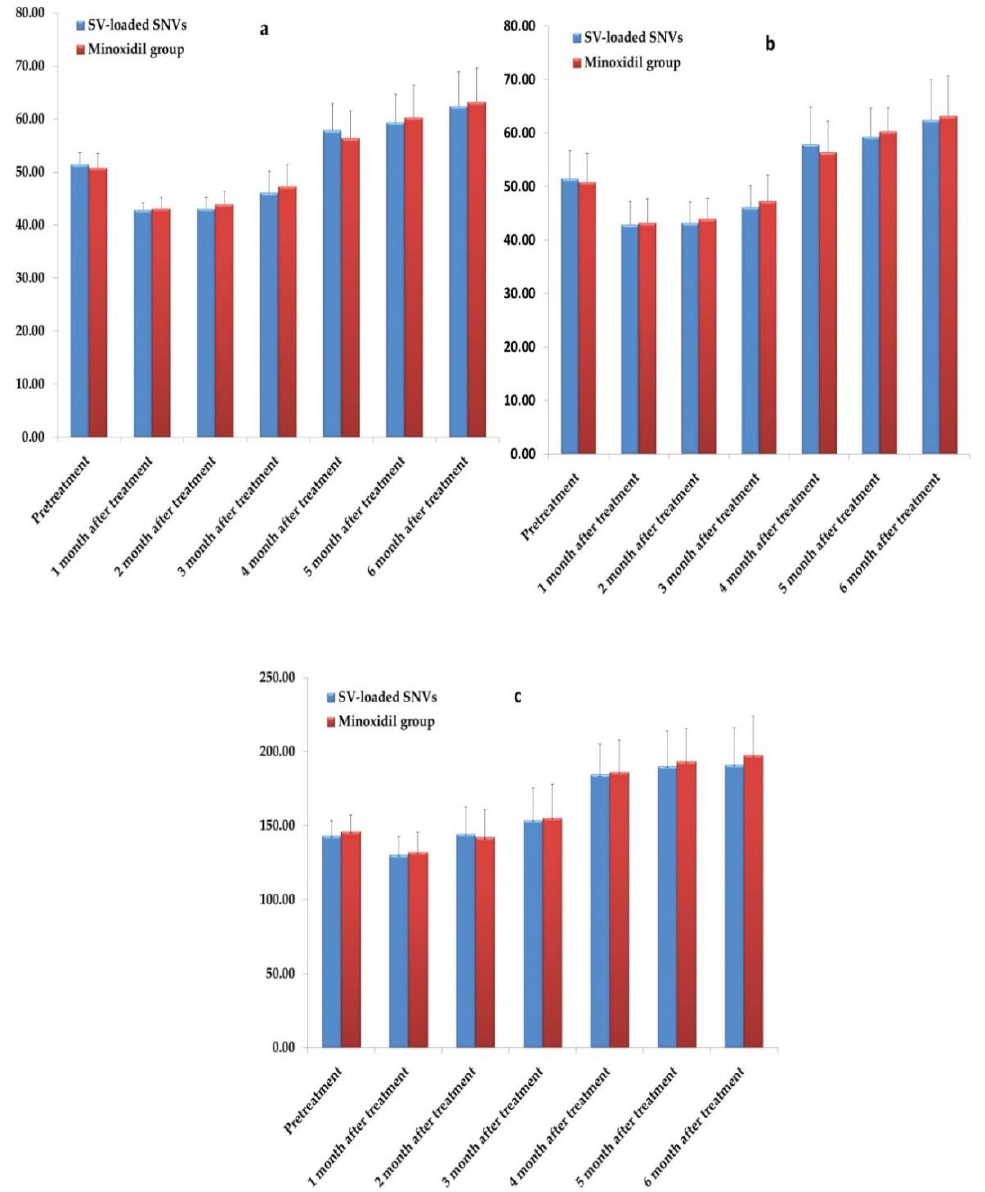
Figure 13. Follow up of ( a ) the number of hair follicles, ( b ) the hair shaft diameter, and ( c ) the hair follicle density for SV-loaded SNVs ( n = 40) and minoxidil ( n = 40) groups. Abbreviations: SV, Sodium valproate; SNVs, spanlastic nanovesicles.